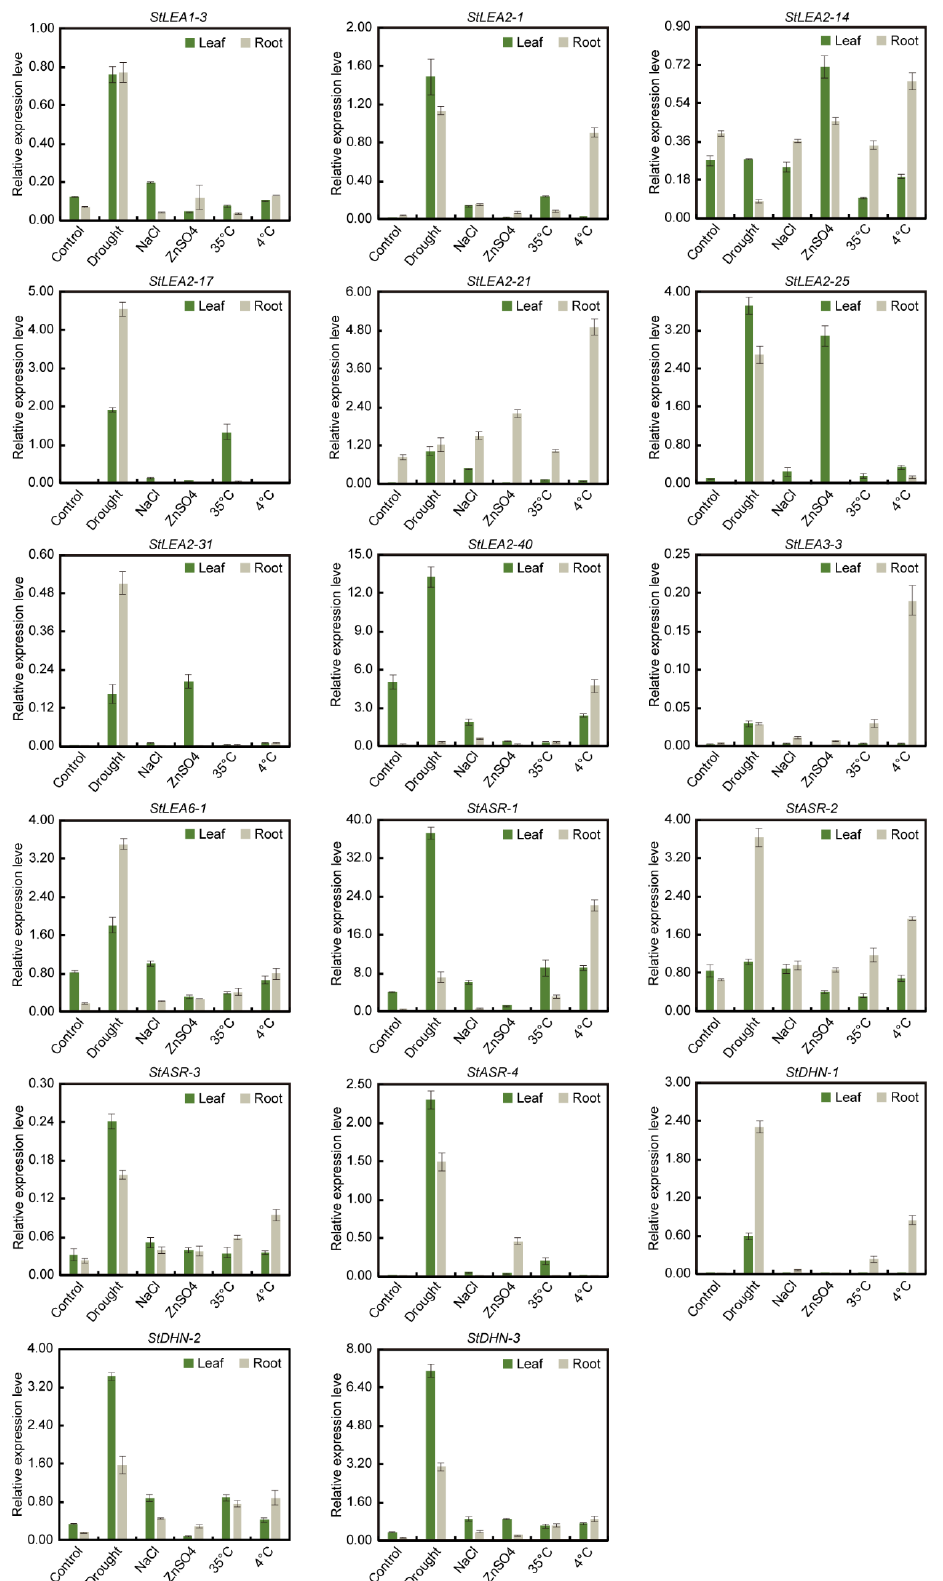
Figure 5. Expression profiles of 17 potato LEA genes under various abiotic stresses. Green and light gray green column indicates leaf and root, respectively. Values represent mean ± standard deviation of three replicates.